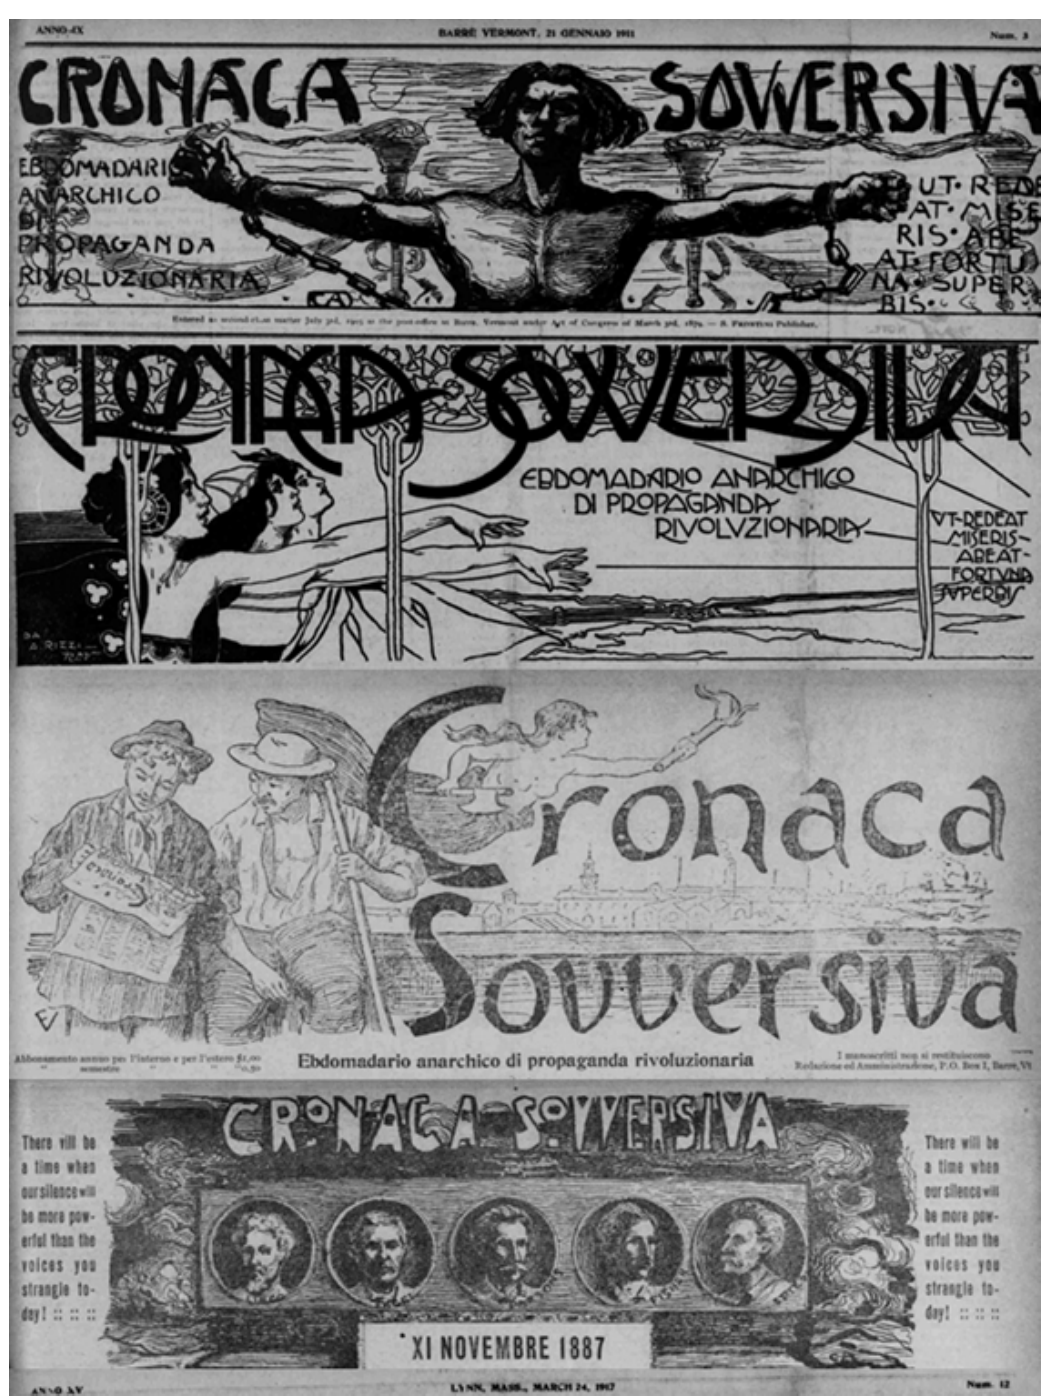
Figure 1 Repeated nameplates of the Cronaca